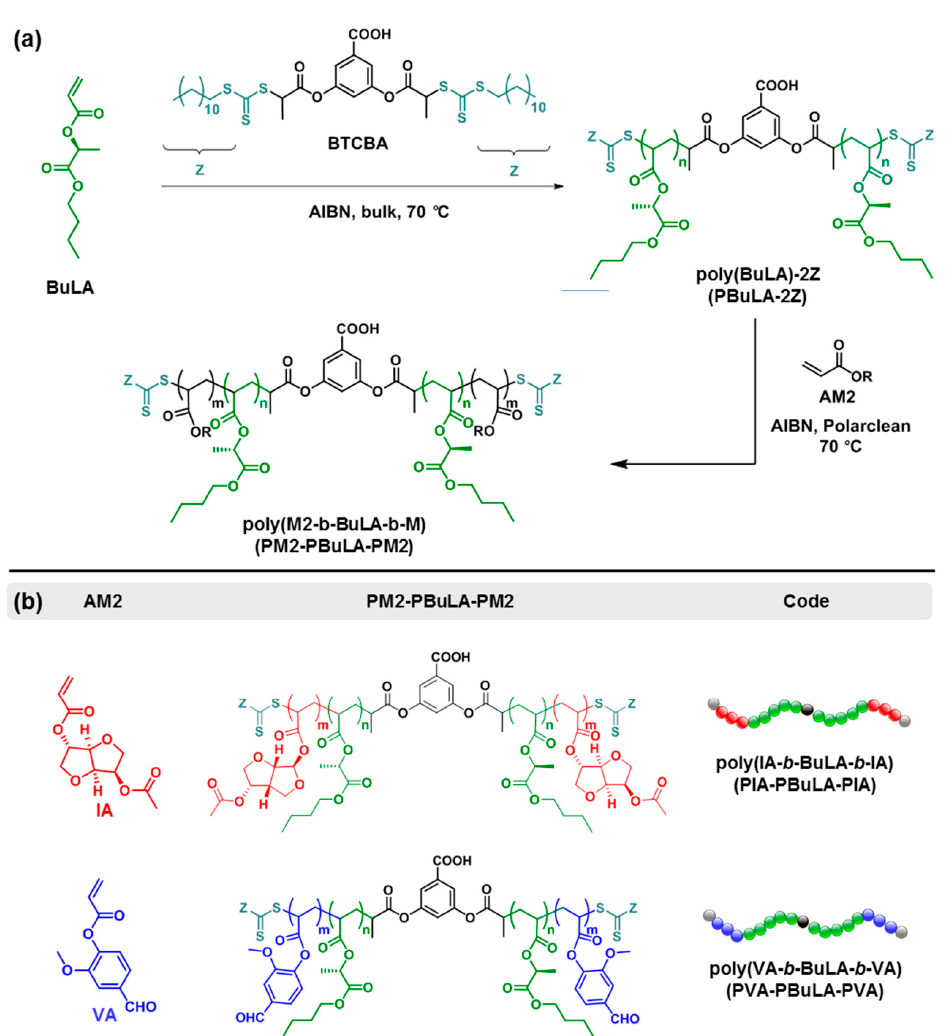
Figure 5. ( a ) Two-step RAFT synthesis of ABA block copolymers with lactic acid-based middle block using AM2 monomer to build up end blocks and BTCBA as a CTA. ( b ) Chemical structures of AM2 acrylic monomers (IA and VA) and ABA block copolymers (PIA-PBuLA-PIA and PVA-PBuLA-PVA) studied herein.